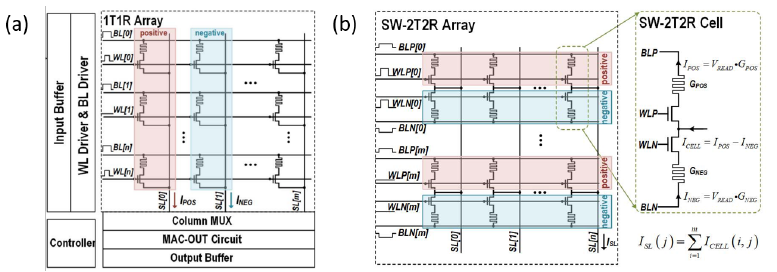
Figure 12. Bipolar conductance mapping and IR drop. ( a ) Typical bipolar conductance mapping in two adjacent 1T1R columns with the positive one (red) encoding the positive part of the weights and the negative one (blue) encoding the negative part of the weights. Currents are then subtracted in the digital domain after conversion. ( b ) To reduce the impact of IR drop, conductance representing the positive and negative weights can be summed up in the analog domain with a dedicated ST-2T2R circuit structure. Reprinted from